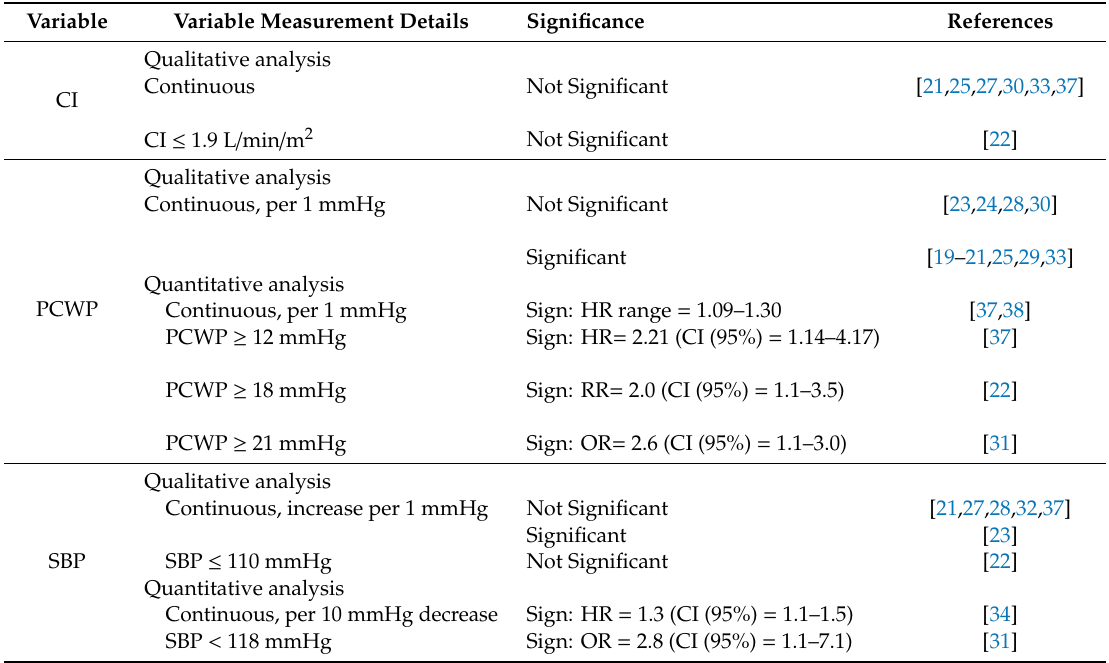
Table 4. Multivariate analysis quantitative and qualitative